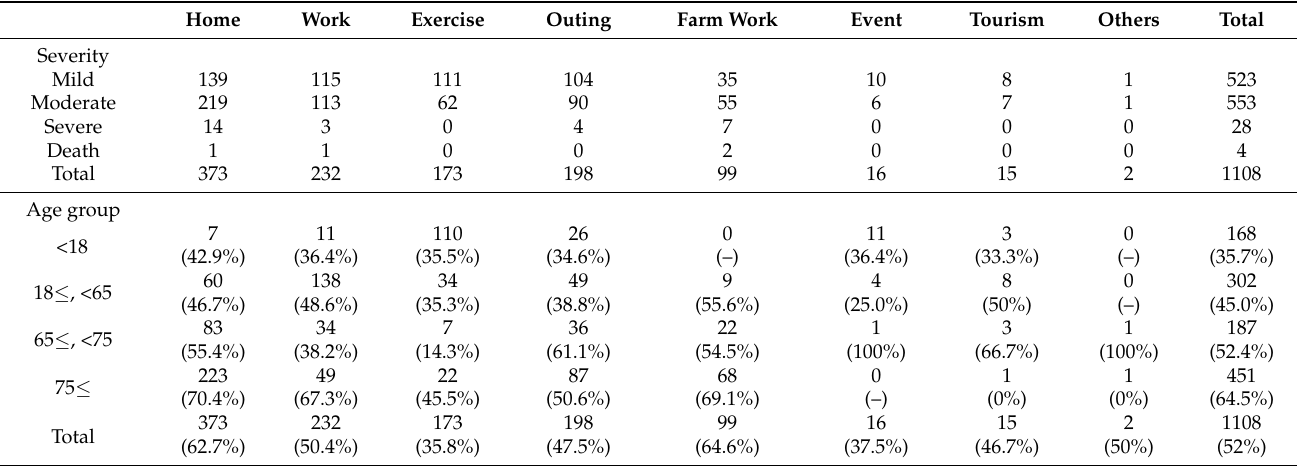
Table 4. Location or activity reported by heat stroke cases and stratified by age and severity.